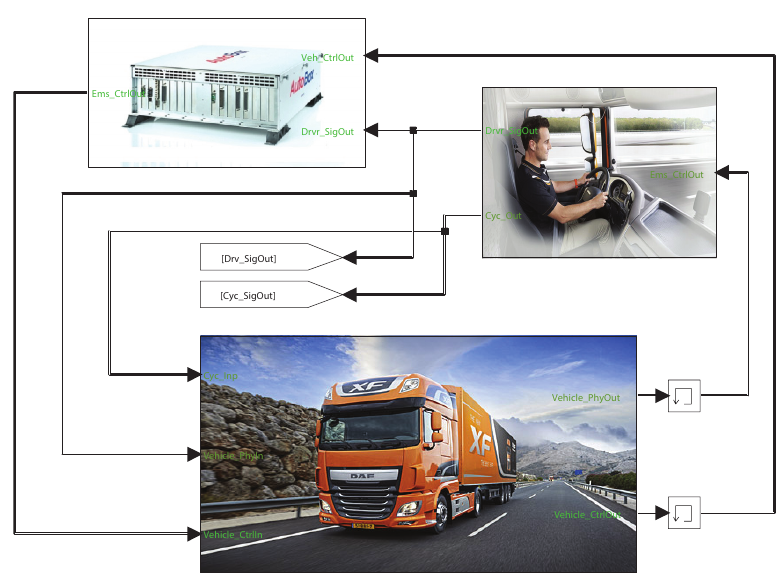
Figure 9. High-fidelity vehicle